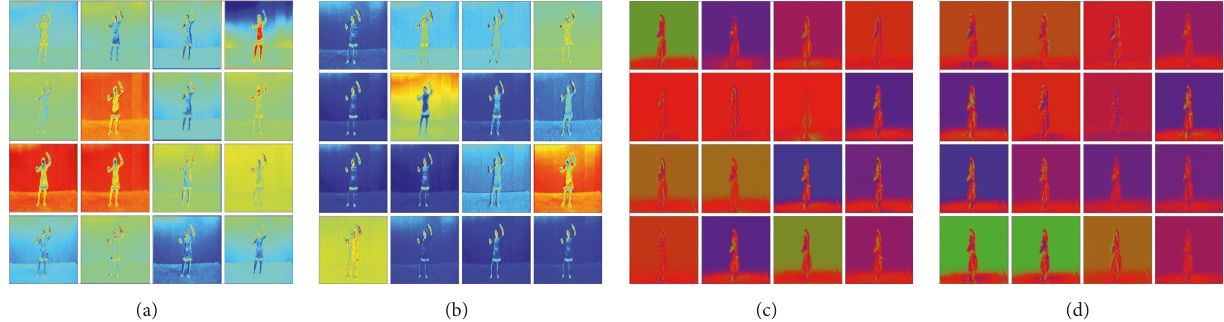
Figure 3: Feature maps. ((a) and (b)) Outputs of convolutional layers 1 and 2, respectively, for offline data. ((c) and (d)) Outputs of convolutional layers 1 and 2, respectively, for online data with 16 filters each.